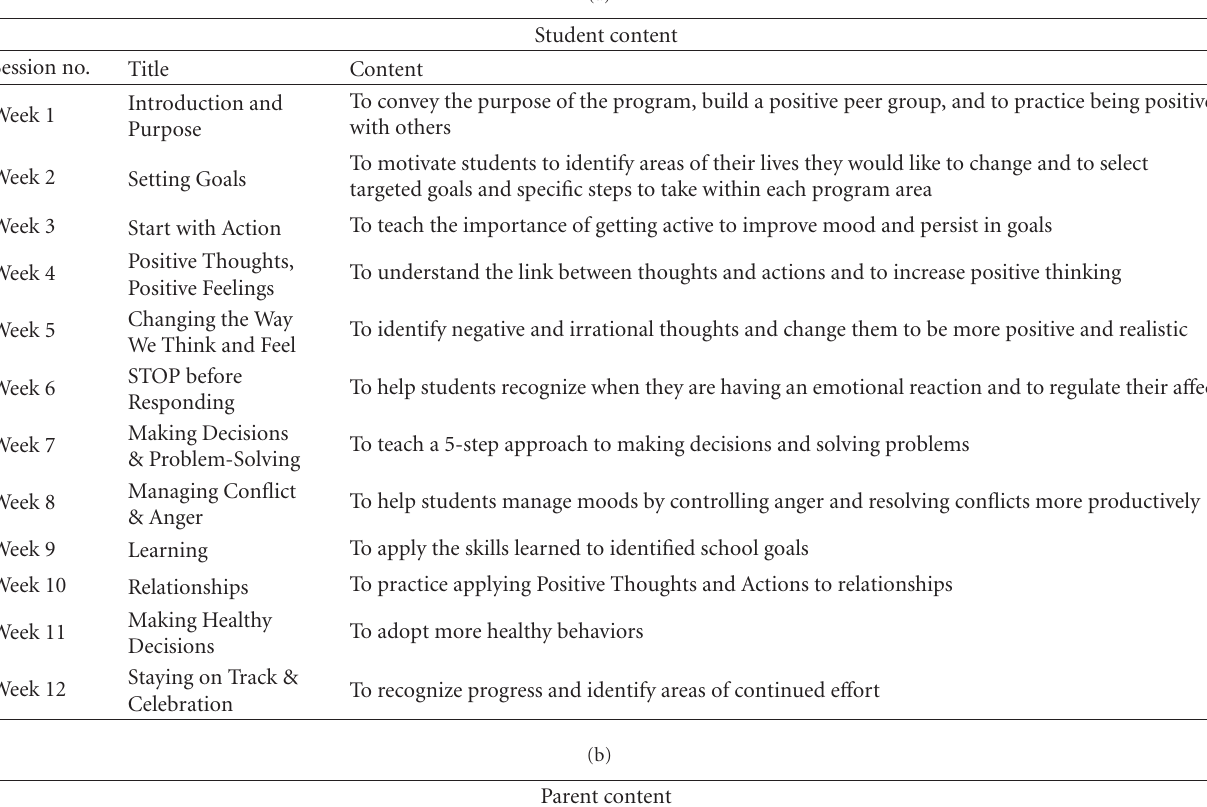
Table 2: Outline of the Positive Thoughts and Actions prevention program